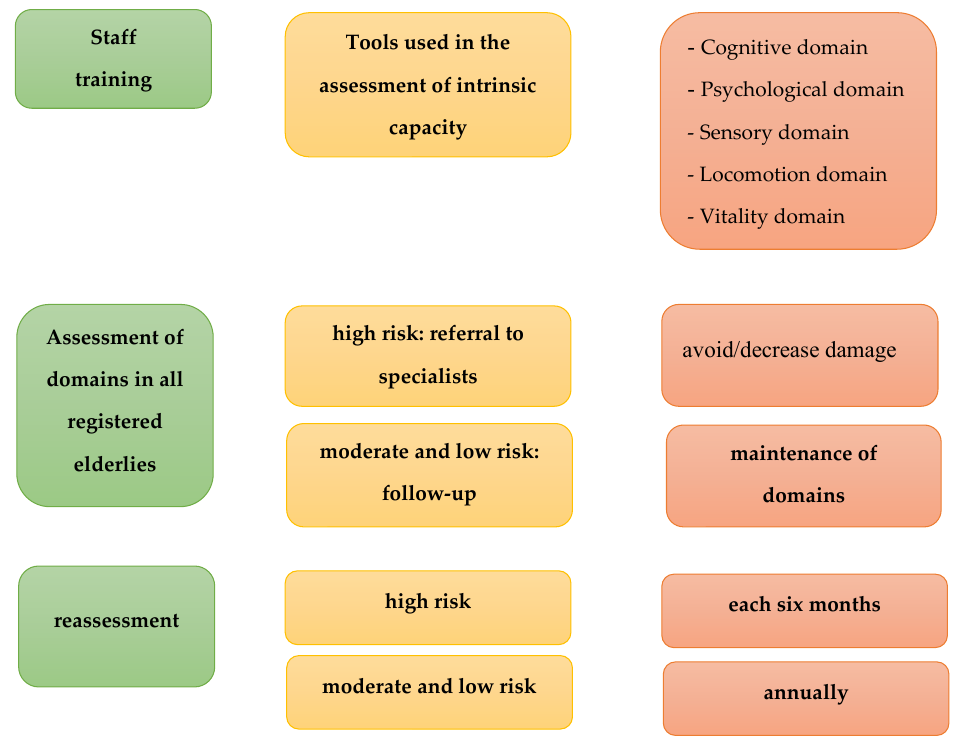
Figure 6. Algorithm for implementing and monitoring the domains of intrinsic capacity in public health.